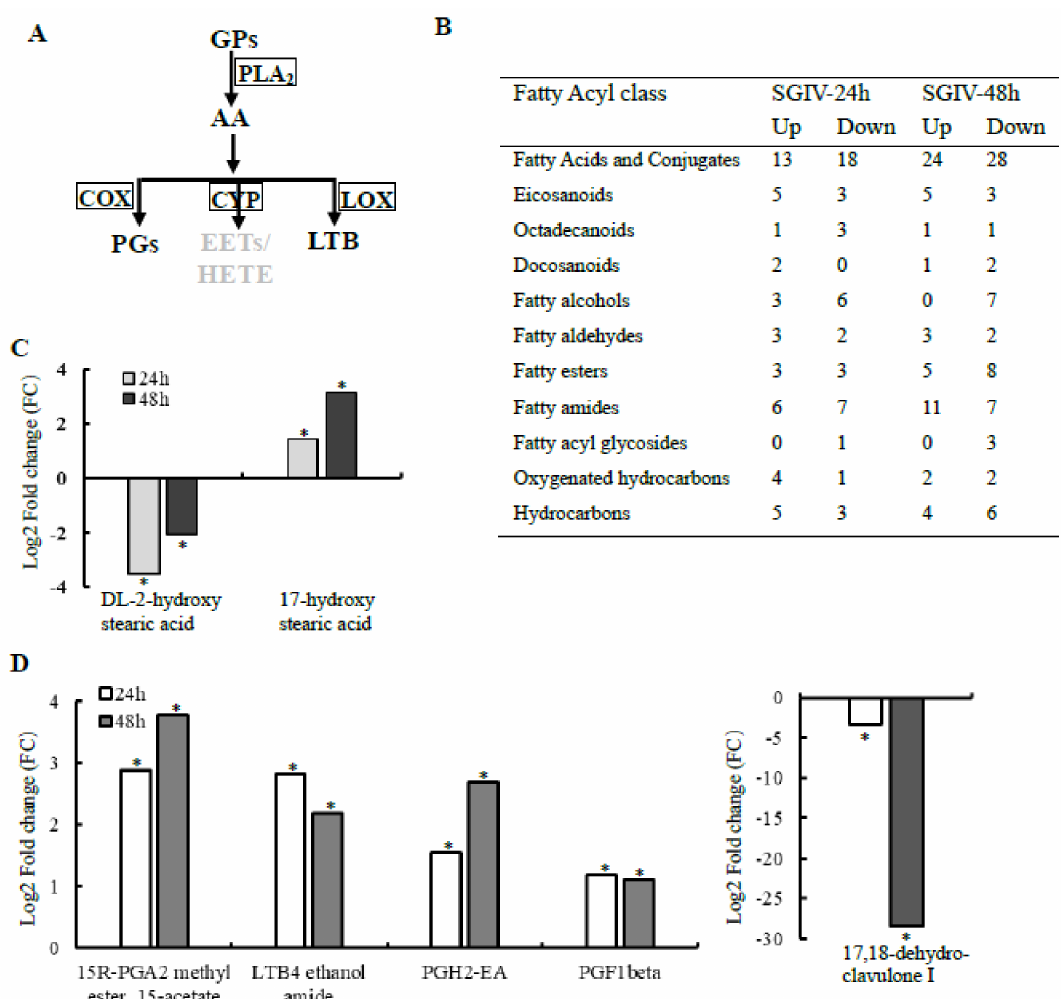
Figure 2. Lipidomic analysis showed that fatty acid (FAs) were significantly elevated in SGIV-infected cells. ( A ) The fatty acid remodeling of GPs. ( B ) The number of lipid species within 11 FAs subclasses that were significantly different between SGIV- and mock-infected cells. ( C ) The abundance of lipid molecules belonging to octadecanoids in SGIV-infected cells. ( D ) The abundance of lipid molecules belonging to eicosanoids in SGIV-infected cells. Asterisks (*) indicated a significant change in abundance between SGIV-infected and mock-infected cells. Abbreviations: PGA2: prostaglandin A2, PGH2: prostaglandin H2, PGF: prostaglandin F, LTB4: